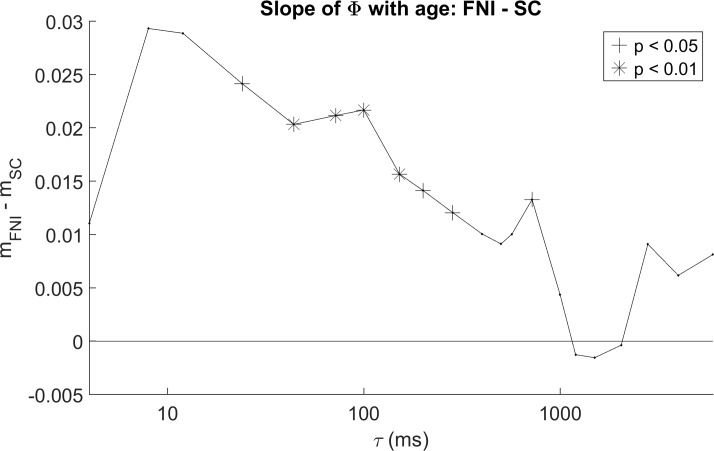
Group differences in Φ by age during sleep.Group comparisons (FNI minus SC) of slopes of Φ with postmenstrual age for all computed values of τ. Results were pooled across sleep states (AS and QS). Significant differences (two sample t-tests) are denoted by asterisks (p < 0.01) and crosses (p < 0.05).